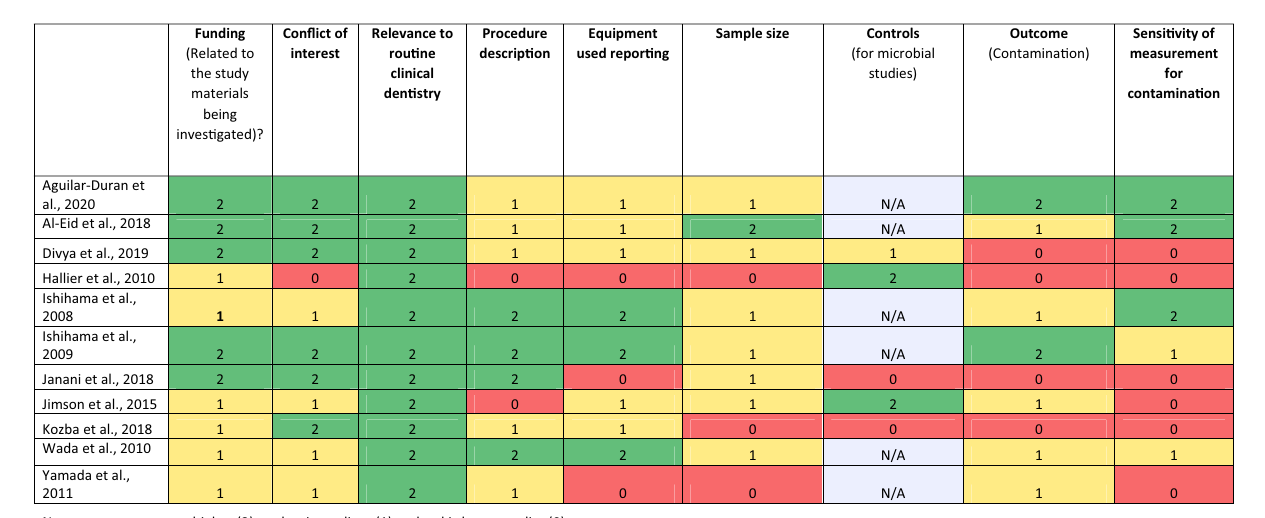
Table 2. Quality assessment including